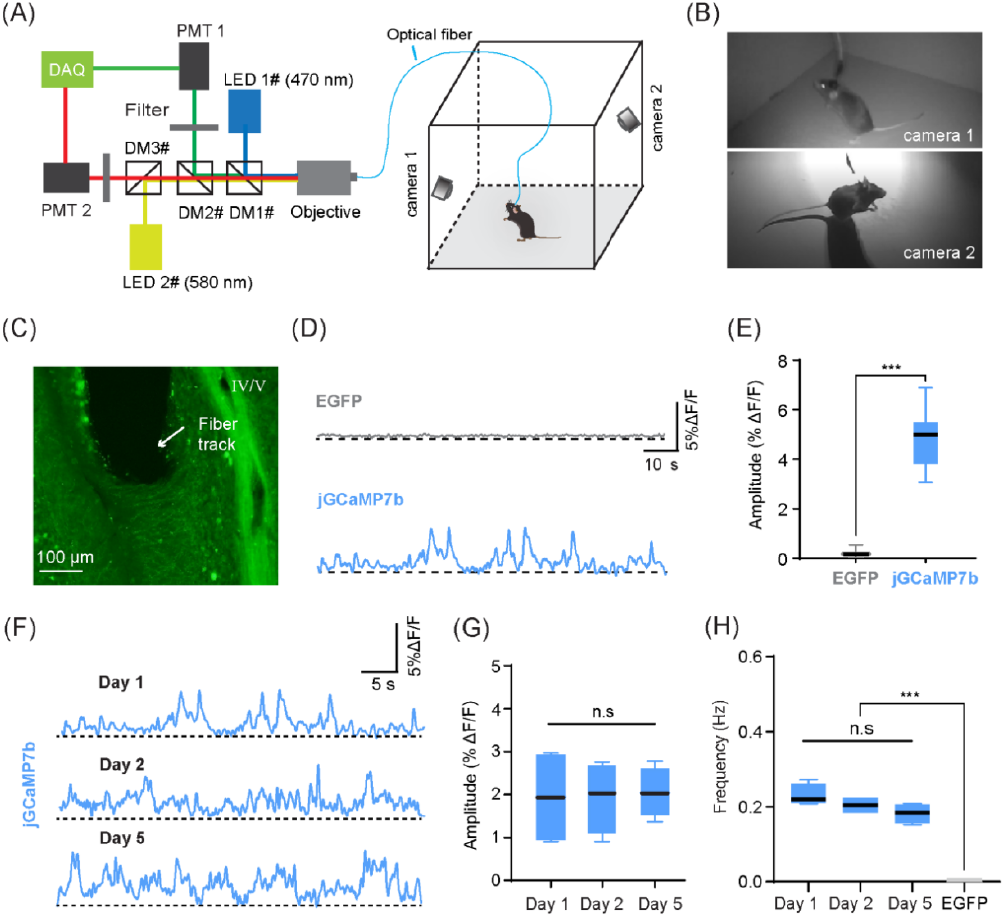
Figure 4. Optical fiber-based Ca 2+ signal recording of climbing fibers (CFs) in freely behaving mice. ( A ) Schematic of the optical fiber recording and the open field behavioral set-up. ( B ) The actual view of mouse movement captured by two cameras. ( C ) Fluorescence image of a sagittal brain slice of lobule IV/V with CFs labeled with jGCaMP7b. White arrow indicates the position of the optical fiber. Scale bar = 100 μm. ( D ) Example of EGFP and jGCaMP7b fluorescence changes (ΔF/ F) in lobule IV/V during the freely moving state. ( E ) Comparison of the amplitudes of EGFP and jGCaMP7b fluorescence changes (Mann-Whitney U test, *** p < 0.001, n = 35 events for each group). ( F ) Long-term Ca 2+ recordings over 5 days. Three example traces that were obtained when the mouse was freely moving in an open field on day 1, 2, and 5 after fiber implantation. ( G ) Comparison of the average amplitude of Ca 2+ signals over 5 days (ordinary ANOVA test, p = 0.9780, n = 4 mice). ( H ) Comparison of the frequency of Ca 2+ transients over 5 days (mean number of transient peaks occurring across 25 randomly sampled time windows (5 s each); Brown-Forsythe and Welch ANOVA test, p = 0.0825, n = 4 mice). EGFP as control (Brown-Forsythe and Welch ANOVA test, *** p < 0.001, n = 4